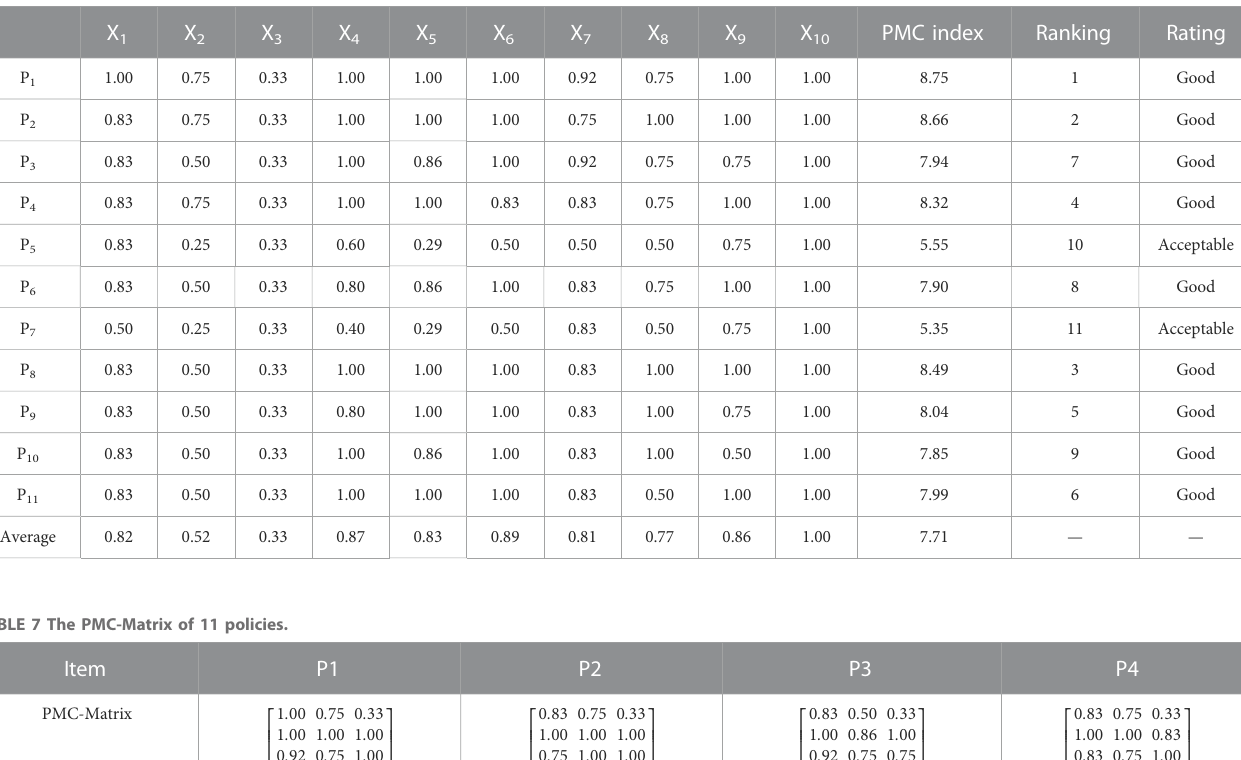
TABLE 6 Summary of PMC index of 11 policies.